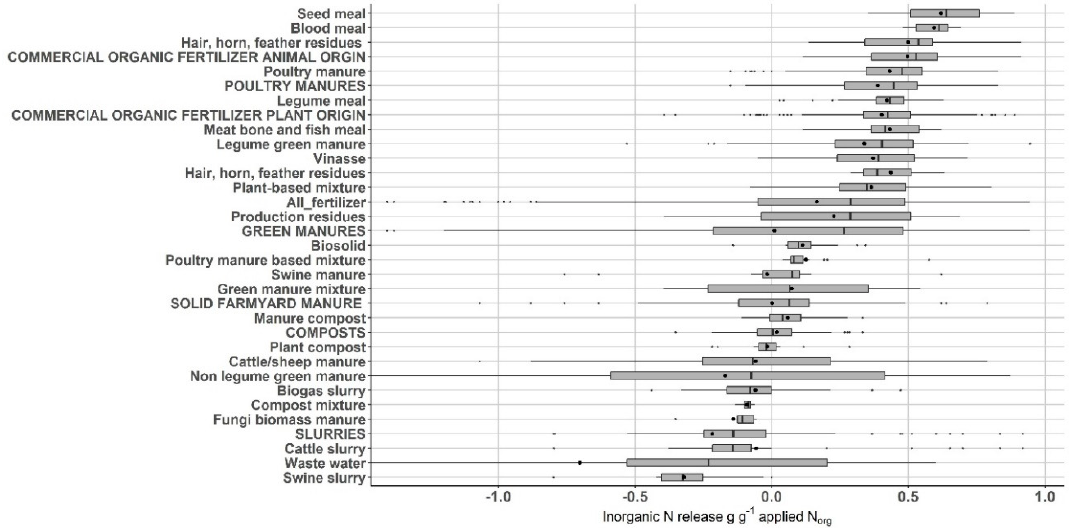
Figure 4. Boxplot of potential inorganic N release ( N 0 ) of the fertilizer main groups (capital letters) and subgroups. The circles are the means and the stripes are the medians of the observations.